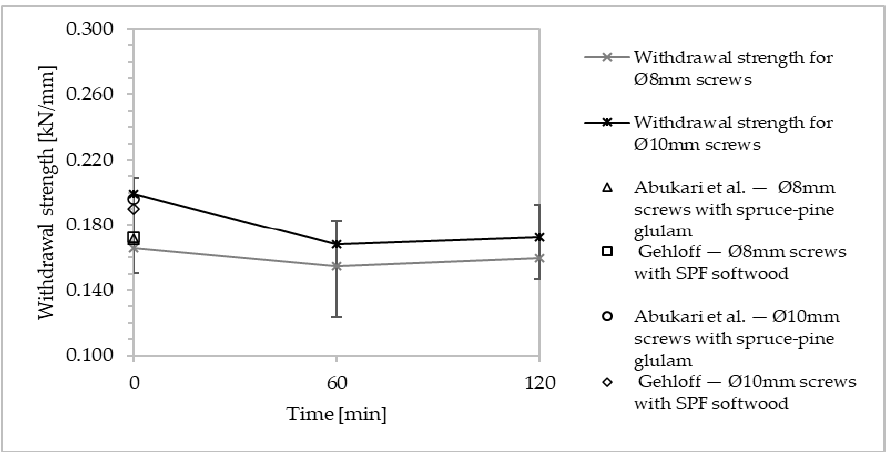
Figure 18. Withdrawal strength of Ø 8 and Ø 10 STS under ambient and fire conditions STS with head exposed to fire [24,43].